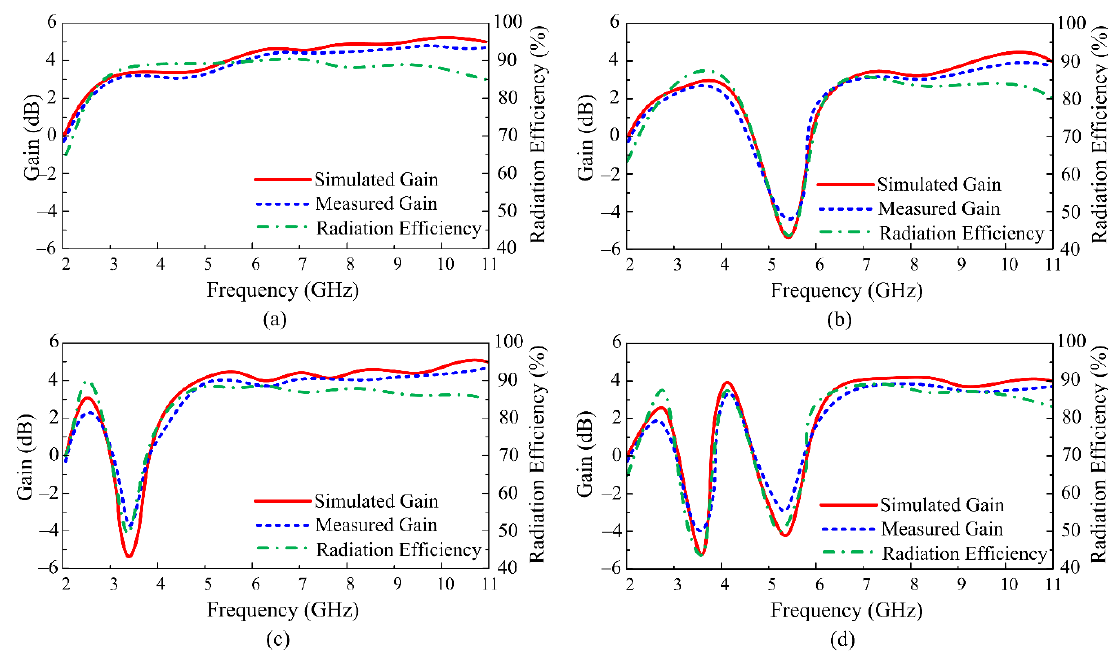
Figure 13. Comparison between the simulated and measured gain, along with simulated radiation efficiency, for various switching states ( a ) case ‐ 10, ( b ) case ‐ 11, ( c ) case ‐ 00, and ( d ) case ‐ 01. efficiency, for various switching states ( a ) case-10, ( b ) case-11, ( c ) case-00, and ( d ) case-01.